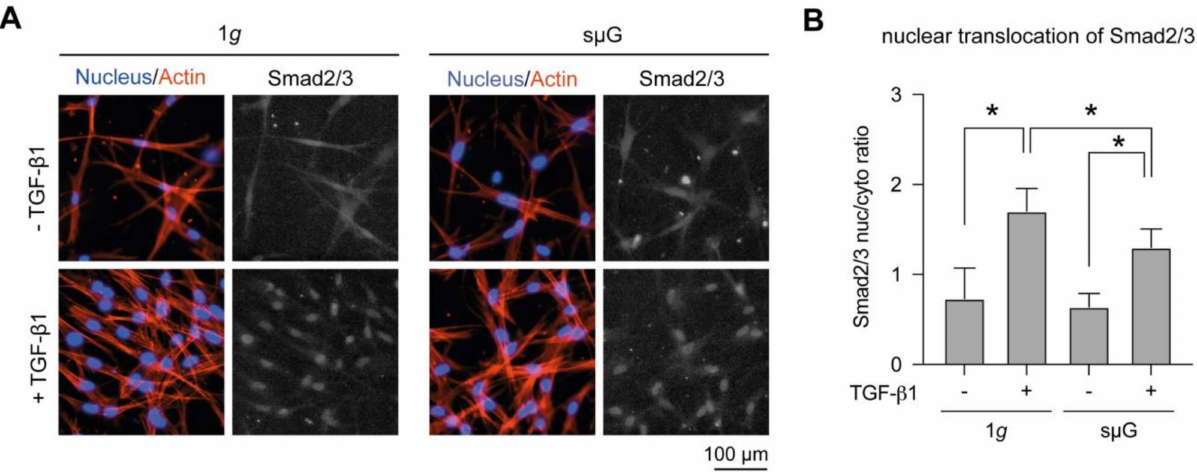
Figure 3. Nuclear translocation of Smad2/3 in dependence of TGF- β 1 stimulation under 1 g and s µ G. ( A ) Representative image of cells stained with Hoechst-33342 (blue), Phalloidin (red) and Smad2/3 (grey) antibodies. ( B ) The quantitative image analysis was performed at least in triplicate with four positions per sample. Data are shown as mean +/ − SD. * indicates significant p ≤